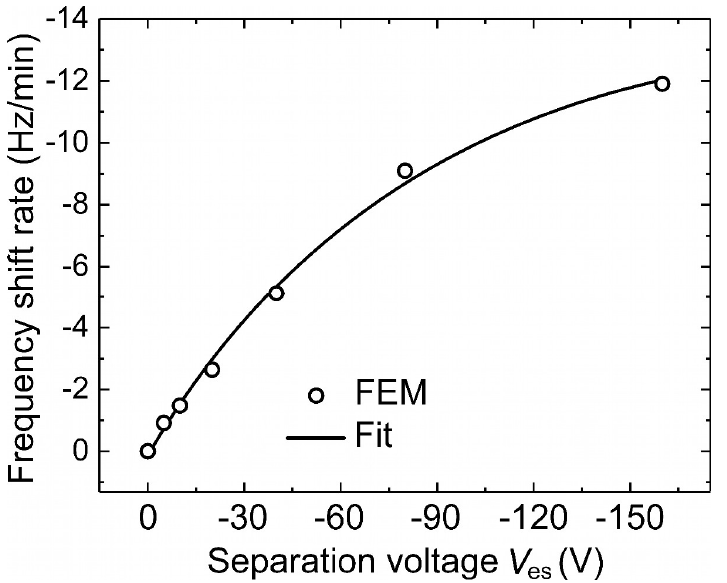
Figure A2. Frequency shift rate determined by FEM for different sampling voltages and fitted curve using Equation (A8).